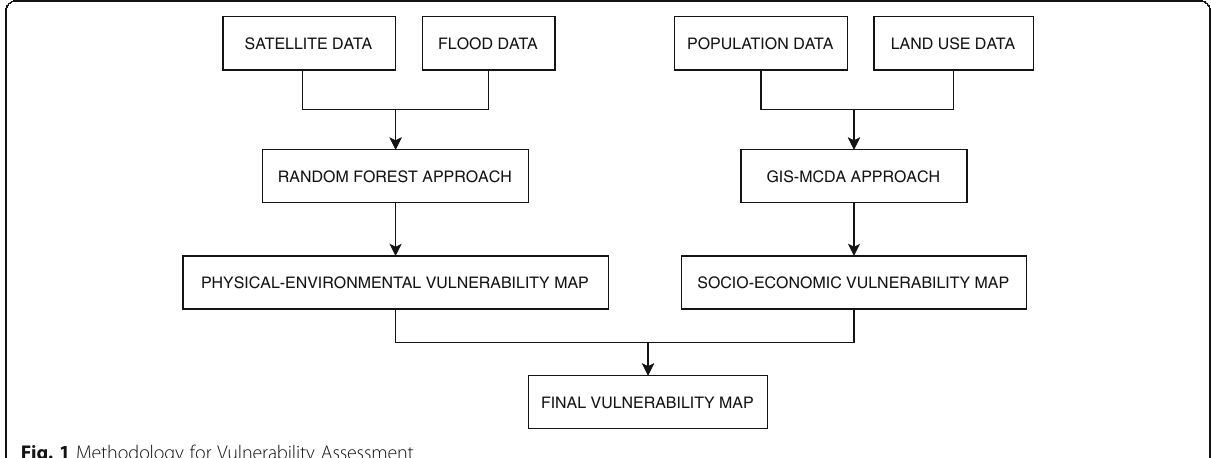
Fig. 1 Methodology for Vulnerability